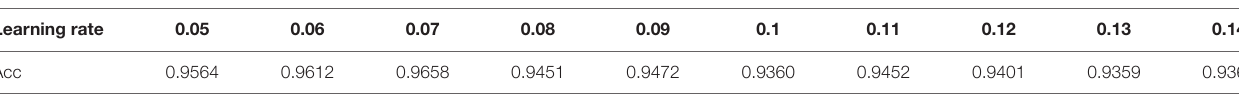
FIGURE 6 | The accuracy rate changes with the number of hidden layers. TABLE 3 | The effect of learning rate on accuracy.